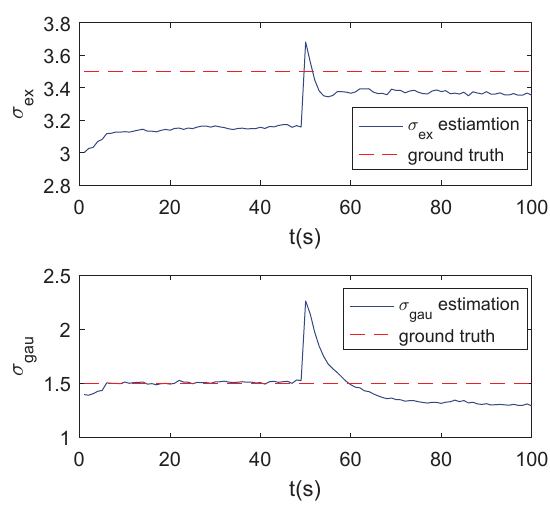
Figure 10. Estimation of σ ex and σ gau for an intensity change